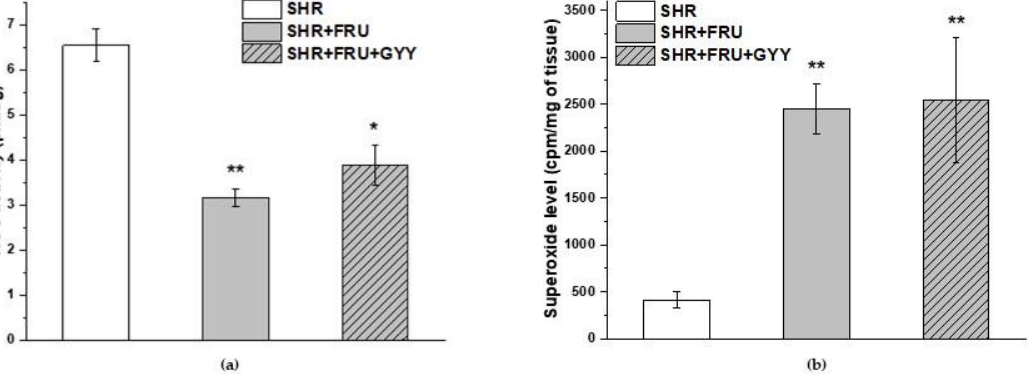
Figure 6. The total NOS activity ( a ) and the superoxide level ( b ) in aortic tissue. Spontaneously hypertensive rats (SHRs), SHRs treated with fructose (SHR+FRU), and SHRs treated with fructose and GYY-4137 (SHR+FRU+GYY). The data are presented as the mean ± S.E.M. Statistical analysis was performed by one-way ANOVA. * p < 0.05 and ** p < 0.01 vs. SHR. There was a significant decrease in NOS activity in the left ventricle ( p < 0.05) ob- (eNOS), neuronal NOS (nNOS), and inducible NOS (iNOS) in the left ventricle were sig- nificantly increased in both the fructose-fed SHRs and GYY-4137-treated groups in com- parison to the SHR group ( p < 0.001) (Figure 7b – d).